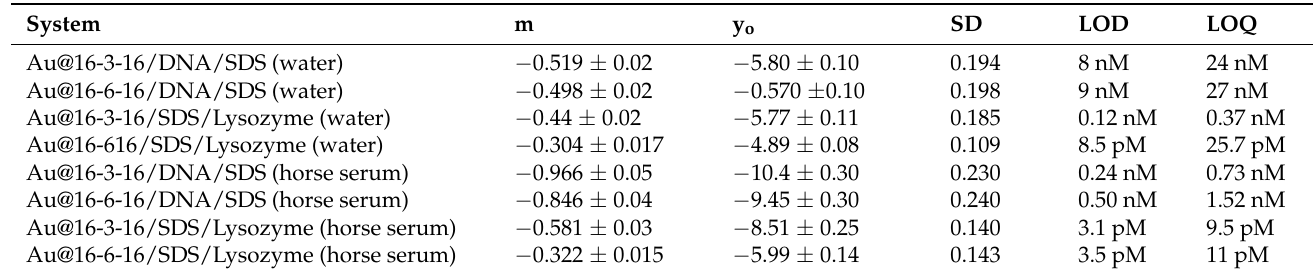
Table 7. Values for limit of detection (LOD), limit of quantitation (LOQ), and linear regression parameters (slope = m and y intercept = y o and standard deviation = SD) for DNA and Lysozyme quantification based on colorimetric response obtained from data in Figures 9 and